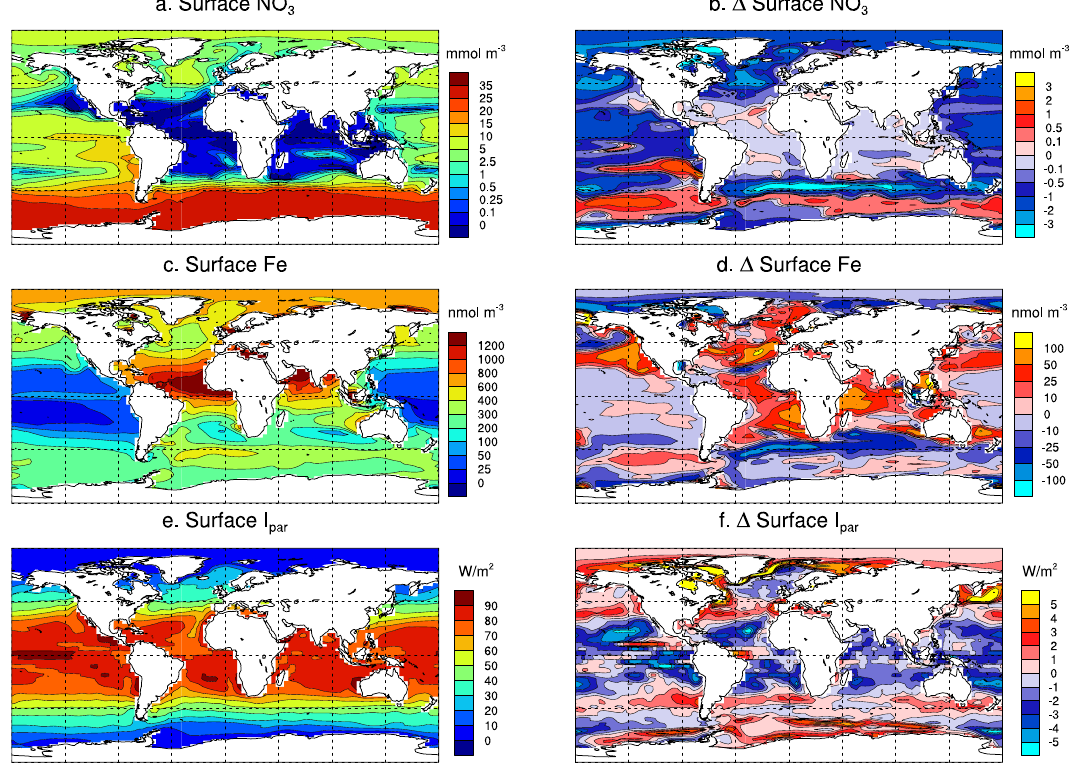
Fig. 4. (a–b) : surface nitrate in mmol/m 3 averaged over 1980–1999 and the change in nitrate between years 1980–1999 and 2080–2099. Same as above for (c–d) the surface iron in nmol/m 3 and (e–f) surface irradiance I par in W/m 2 . Surface irradiance takes into account the decreasing ice